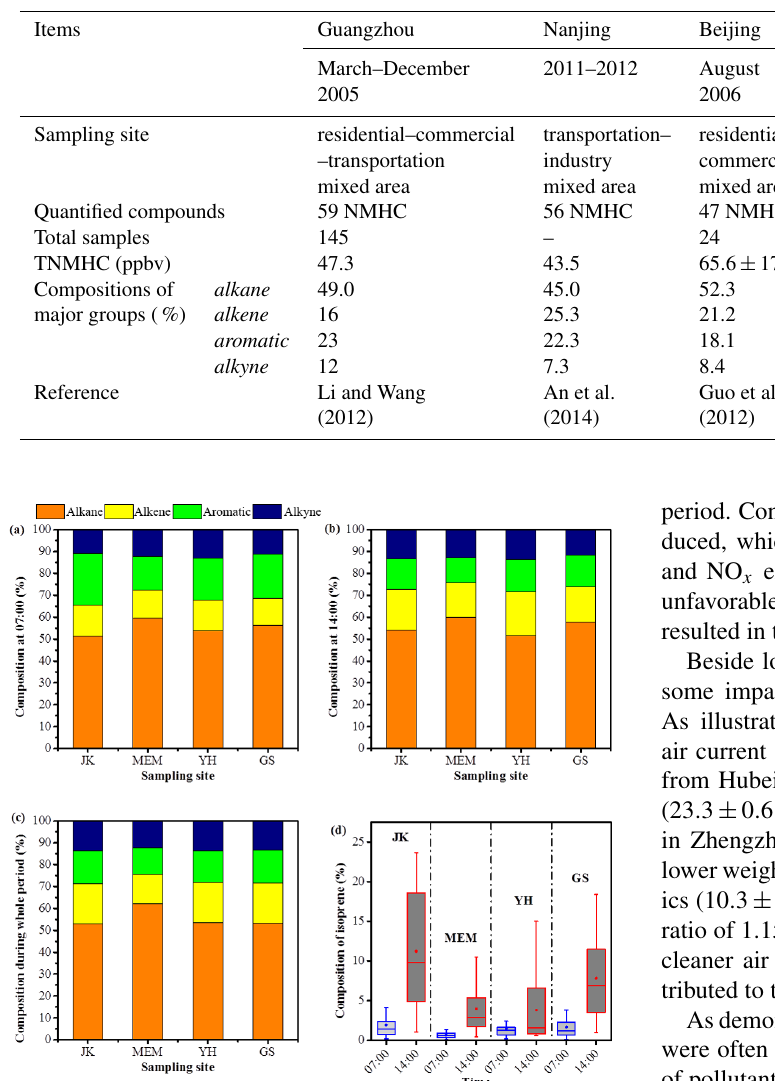
Table 3. Concentration levels of VOCs and compositions of major groups in Zhengzhou and other cities in China. TNMHC refers to total non-methane hydrocarbon.